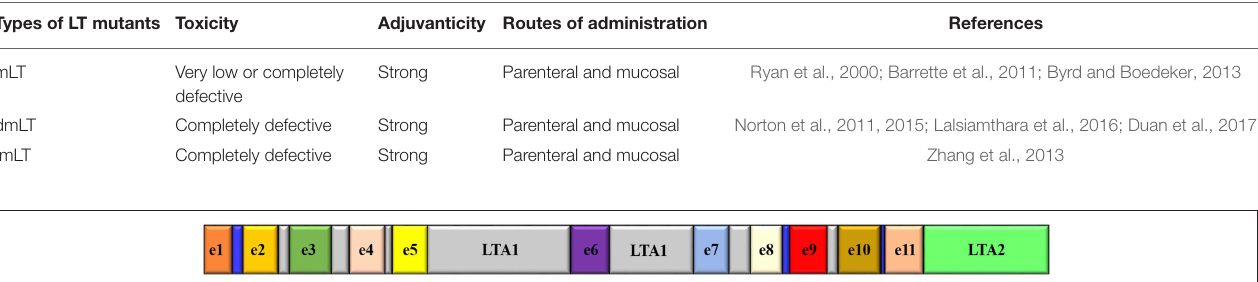
TABLE 3 | The characteristic of types of LT mutants as adjuvant.